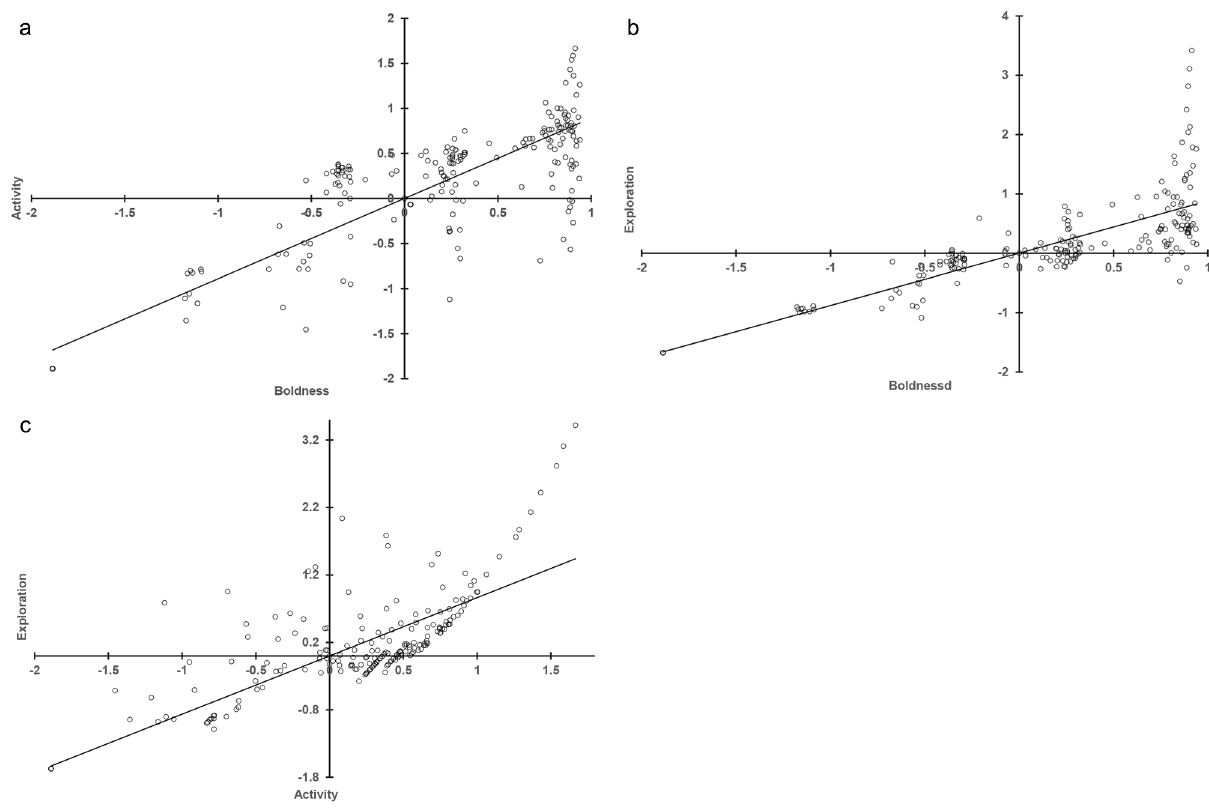
Fig. 4 Correlation of PC scores between paired behavioral categories (a) boldness-activity, (b) boldness-exploration, and (c) activity-exploration assessed for eastern bent-wing bats in flight-tent